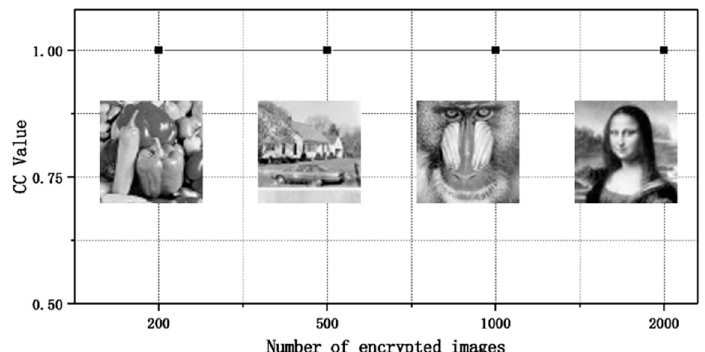
Figure 12. Decryption results of 200, 500, 1000, and 2000 different images with 64 × 64 pixels and their CC